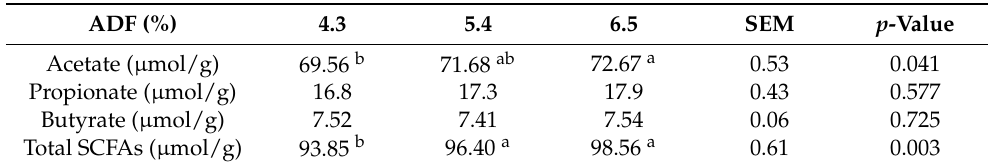
Table 4. Effect of dietary acid detergent fiber (ADF) levels in gestation diets on fecal SCFAs concen- tration (d 112).